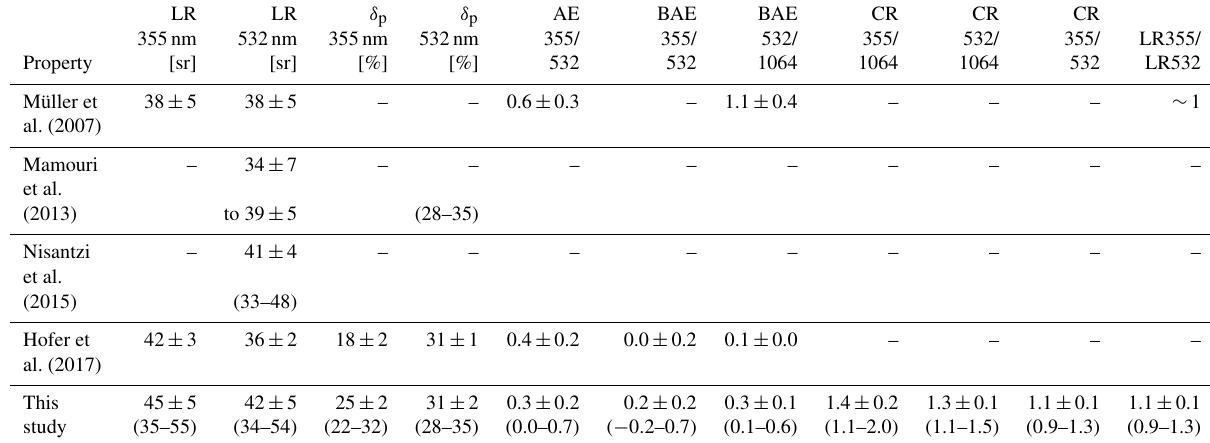
Table 1. Aerosol particle properties of the Arabian dust and comparison to previous studies. Both 355 and 532nm wavelengths are reported in terms of their lidar ratio (LR), linear particle depolarization ( δ p ), and the ratio of their lidar ratios. Combinations of Ångström exponents from both the extinction (AE) and backscatter (BAE) coefficients along with the colour ratios (CRs) are shown due to the multi-wavelength capability of the lidar instrument. The numbers in the brackets show the range of values found for each optical property. LR